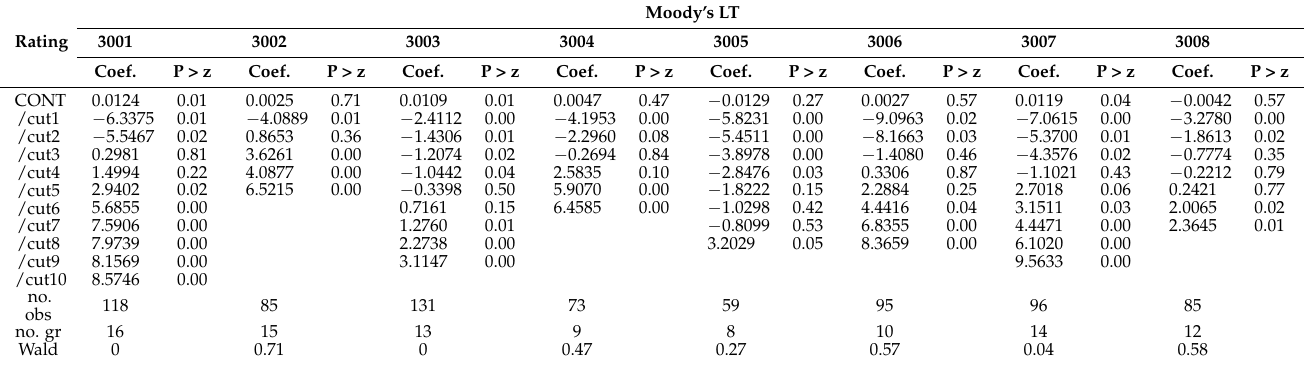
Table 10. Impact of the ESG Controversies Score on Moody’s long-term issuer credit ratings by